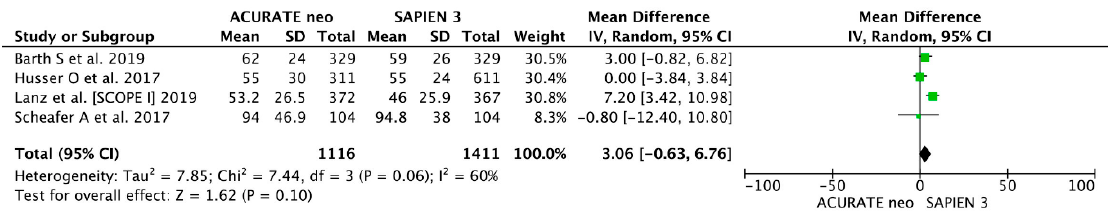
Figure A4. Procedural outcomes. Detailed analysis of individual weighted mean differences (MDs) with corresponding 95% CIs on procedure duration for the comparison of ACURATE neo vs. SAPIEN 3.